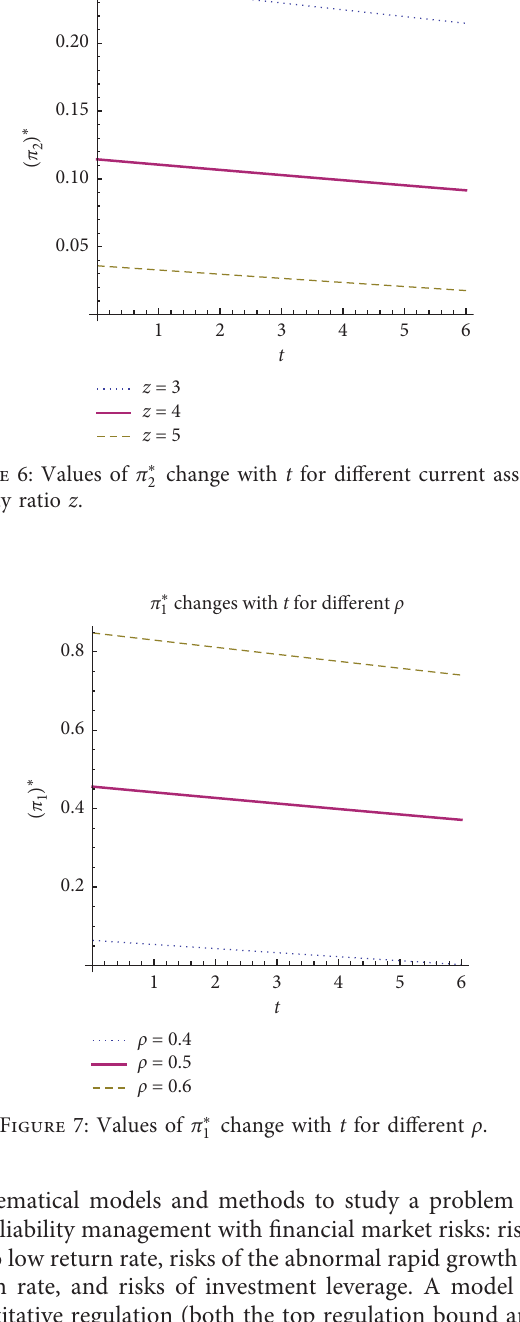
change with t for different ρ . 1